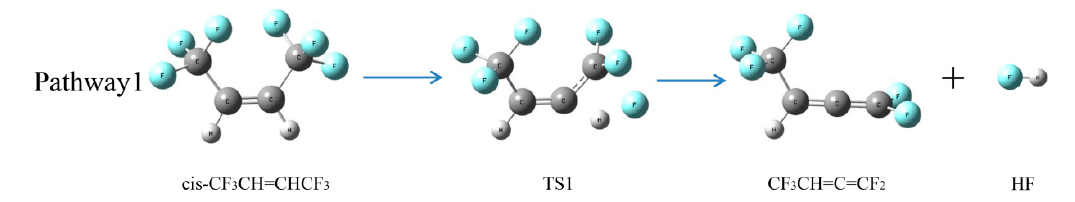
Figure 10. Intramolecular elimination of HFO-1336mzz(Z). C, H and F atoms are represented with black, gray and blue balls, respectively.